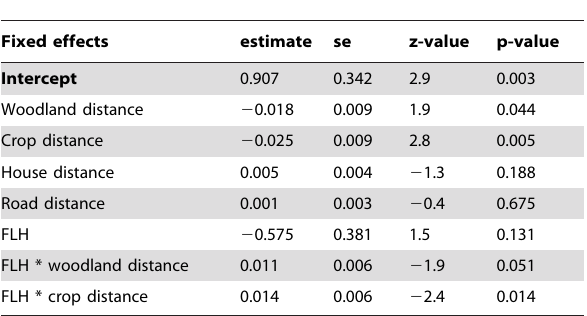
Table 1. Model (binomial GLMM) on nest predation risk of wheatear nests (n=923) in relation to different habitat